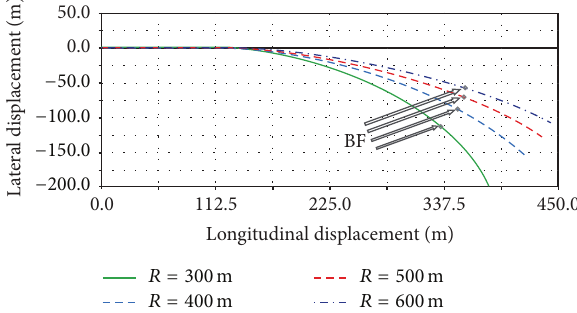
Figure 5: Braking trajectory of the vehicle in different radius curves.